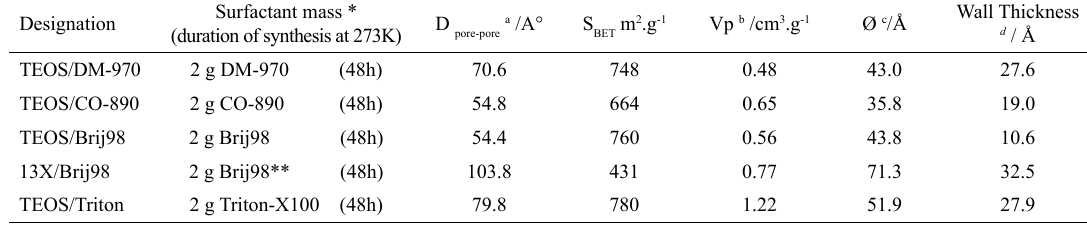
O; 120 ml HCl; 9g 2 –Ø. pore-pore